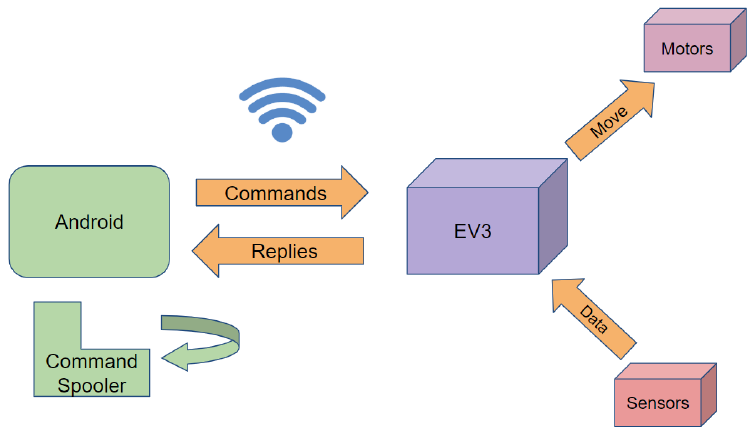
Figure 1. Components of an Android + LEGO Mindstorms system using